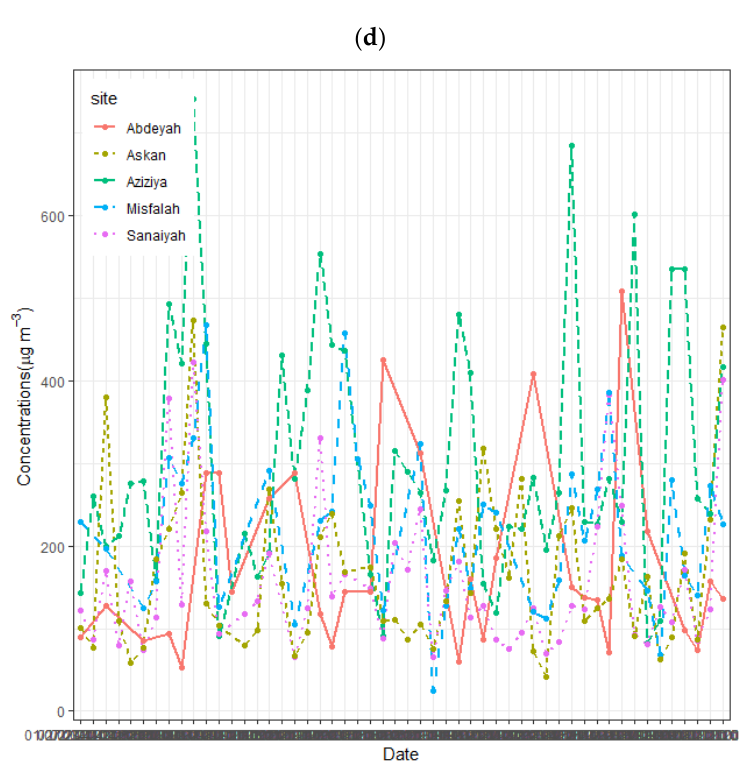
Figure 2. Comparing the levels of different ions using bar plots ( a , b ), PM 10 concentrations using box plots ( c ), and time series of PM 10 ( d ) at different sites in Makkah. The lower end of the box shows 1st quartile, the upper end of the box shows 3rd quartile, and the horizontal line in the middle of the box shows the median of the data. The top and lower ends of the vertical orange line show maximum and minimum values, respectively, whereas the dots above the vertical line shows outli- ers. Table 1. Sum of ion concentrations (µg/m 3 ) and their percent contribution to PM 10 concentrations (µg/m 3 ) at different monitoring sites.